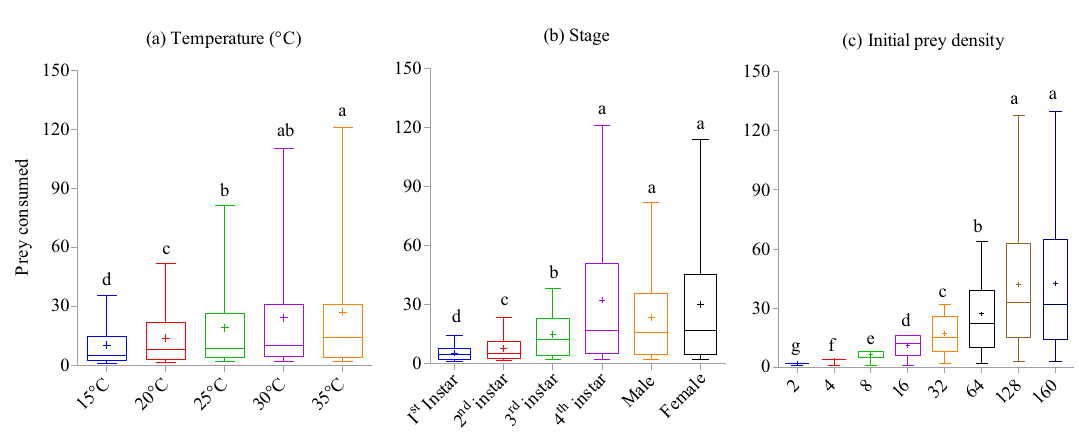
Figure 2. Mean number of Acyrthosiphon pisum nymphs consumed by Harmonia axyridis under different thermal conditions ( a ), growth stages ( b ), and densities of prey offered ( c ). Box plots are showing the range of data (lower and upper quartiles, and extreme values), median, and mean (symbols), and different alphabets indicate significant differences among group means according to Wald chi square test with 95% CI of